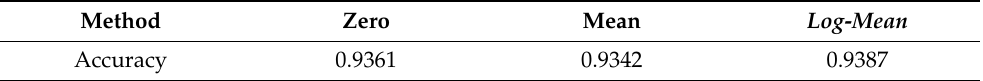
Table 5. Diverse methods to procedure Inf and Nan.